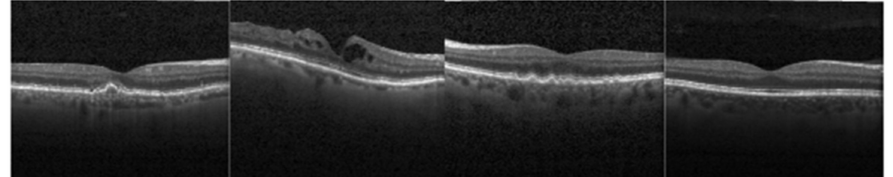
Figure 1. ( Far left ) Choroidal neovascularization (CNV) with neovascular membrance. ( Middle left ) Diabetic macular edema (DME) with retinal-thickening-associated intraretinal fluid. ( Middle right ) Multiple drusen present in early (dry) age-related macular degeneration (AMD). ( Far right ) Normal retina with preserved foveal contour and absence of any retinal